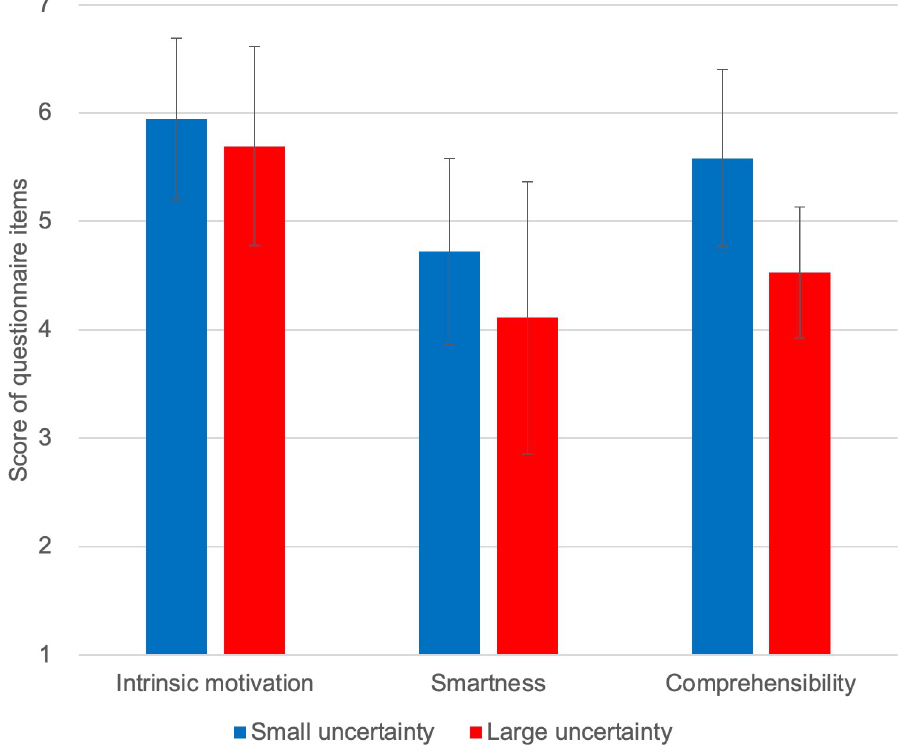
Fig 20. Self-reported intrinsic motivation, smartness, and comprehensibility. Sorted by uncertainty group.